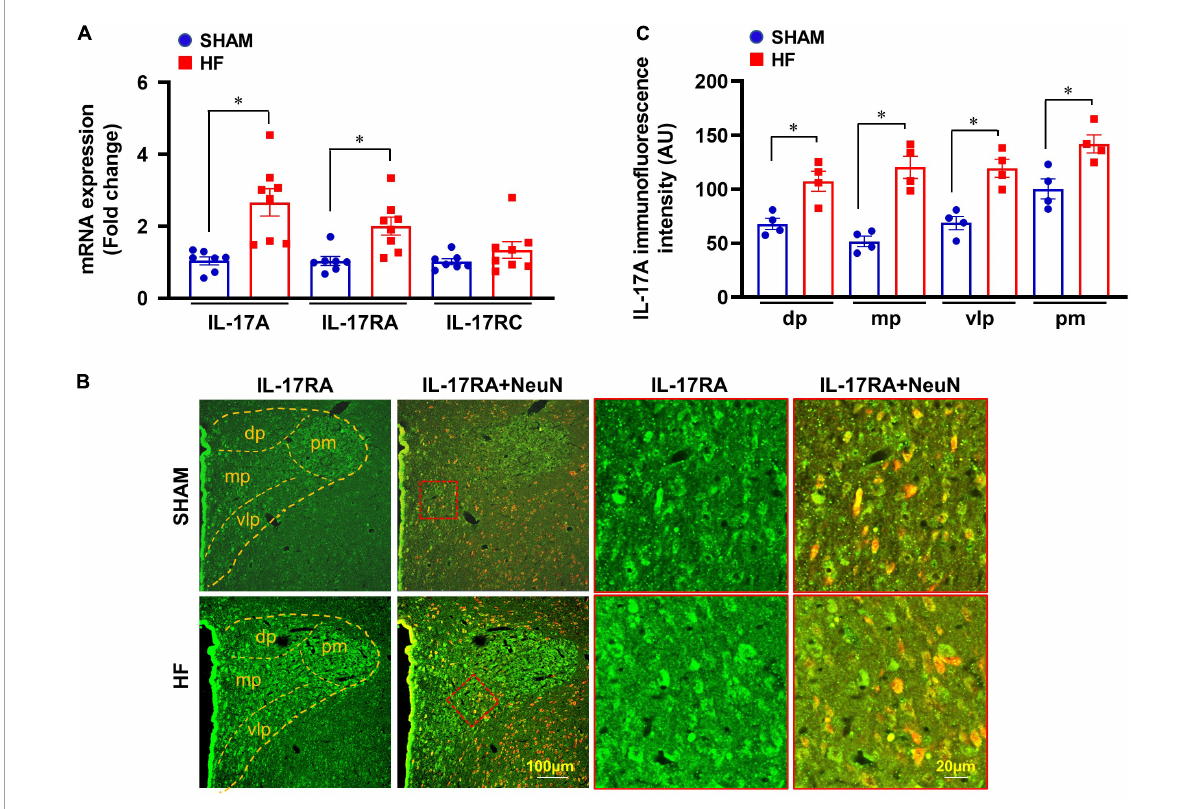
FIGURE2 (A) mRNA expression of IL-17A and its receptors IL-17RA and IL-17RC in the PVN of SHAM and HF rats 4 weeks after CL. (B) Representative confocal images showing expression of IL-17RA (green) and NeuN (a neuronal marker, red) and merged images (yellow) in the PVN of SHAM and HF rats 4 weeks after CL. (C) IL-17RA immunofluorescence intensity in 4 subnuclear regions of the PVN including dorsal parvocellular (dp), medial parvocellular (mp), ventrolateral parvocellular (vlp), and posterior magnocellular (pm), in SHAM and HF rats 4 weeks after CL. Values are expressed as means ± SEM ( n = 4-8 for each group); * p <